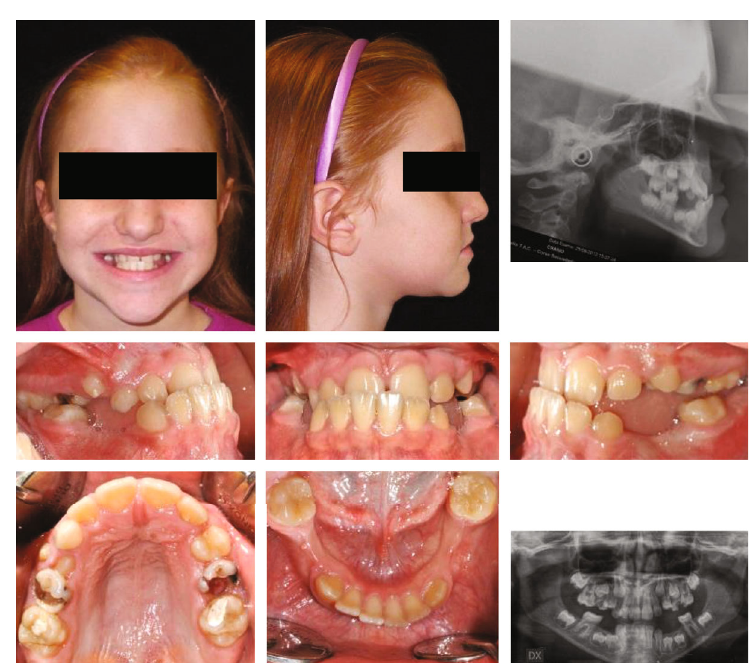
Figure 2: Case no. 1 facial photos, intraoral photos, panoramic radiograph, and lateral cephalogram at T